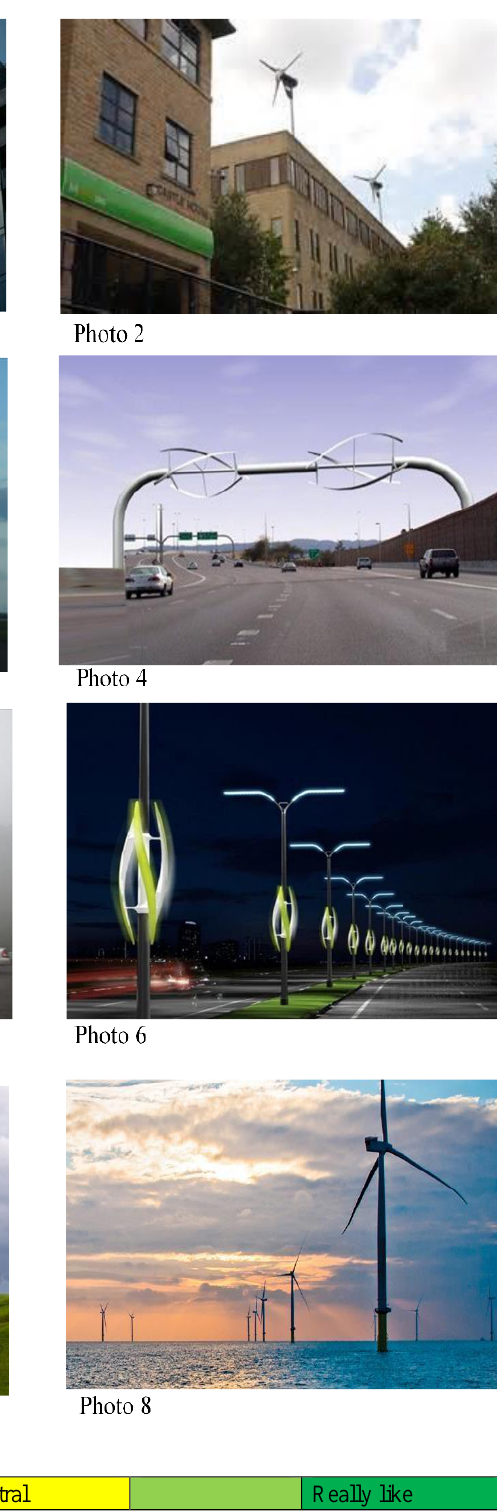
1 Figure 1. Wind turbines displayed in eight different Figure 1. Wind turbines displayed in eight different contexts.